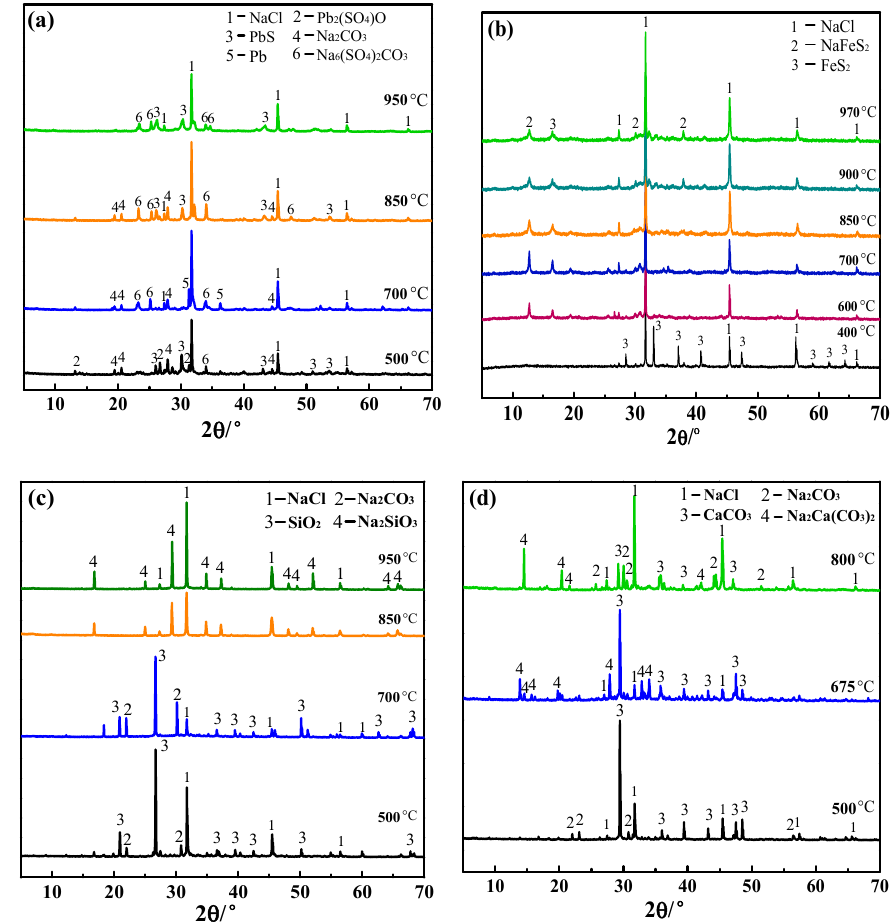
Figure 5. XRD diagrams of products baked with different impurities and molten salts at different temperatures ( a ) PbS with carbon addition, ( b ) FeS 2 with carbon addition, ( c ) SiO 2 without carbon addition, ( d ) CaCO 3 without carbon addition.